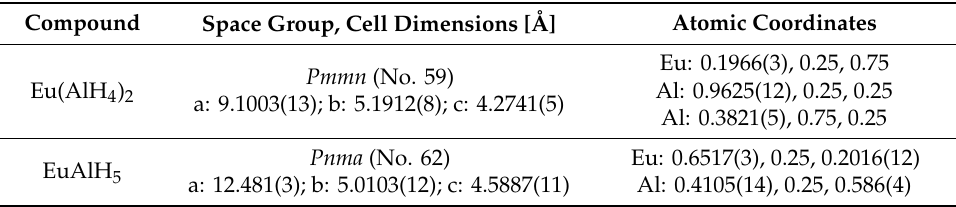
Figure 20. Crystal structure of lanthanides alanates and their calculated diffraction patterns ( λ = Cu k α 1 ). Table 13. Crystallographic data of Europium alanates